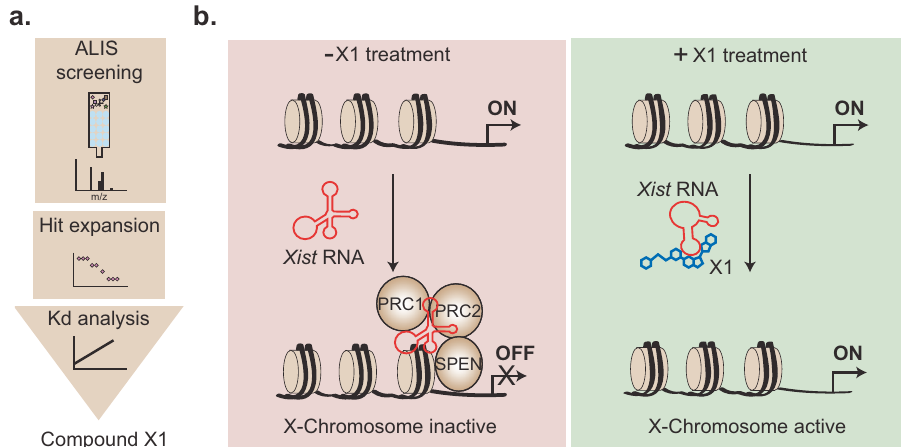
Fig. 1 An ALIS-based RNA-binding screen revealed compound X1 as a small molecule that speci fi cally targets Xist RNA and modulates its activity. a ALIS screening was performed targeting the RepA domain of Xist RNA. Compound X22 was identi fi ed in the screen and further validated. Hit expansion studies with X22 were carried out and resulting af fi nities evaluated and ranked. Ultimately, Kd analyses were used to validate several hits, including the original hit X22, and its analog compound X1. Compound X1 yielded the highest af fi nity to RepA and was used to perform functional assays to modulate Xist RNA both in vitro and in cells. b The Xist RNA recruits PRC1, PRC2 and SPEN to inactivate the X chromosome by epigenetic modi fi cation (left). X1 disrupts the Xist RNA structure upon binding and compromises Xist RNA-protein interactions, resulting in pertained X chromosome activation